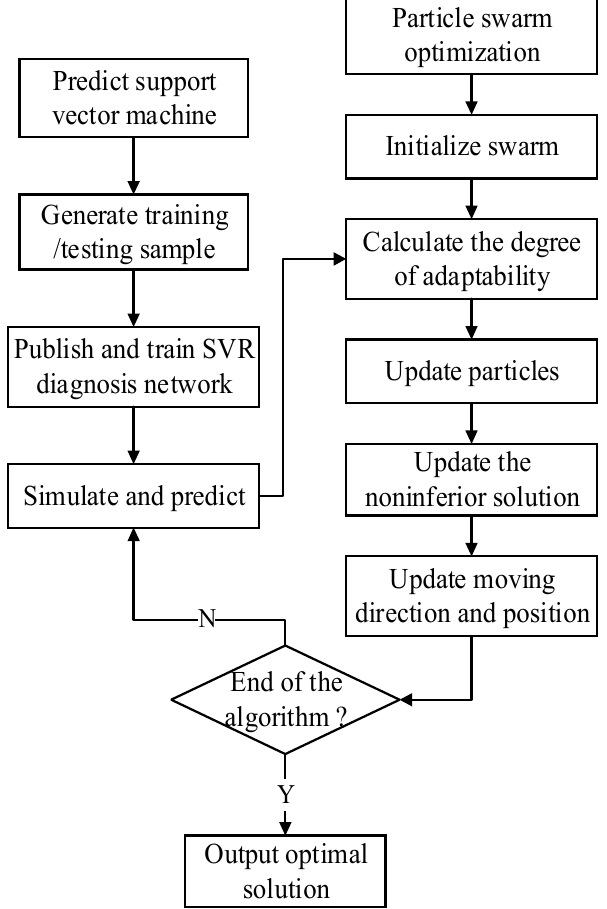
Figure 26. Flow chart of the SVR-PSO model establishment.